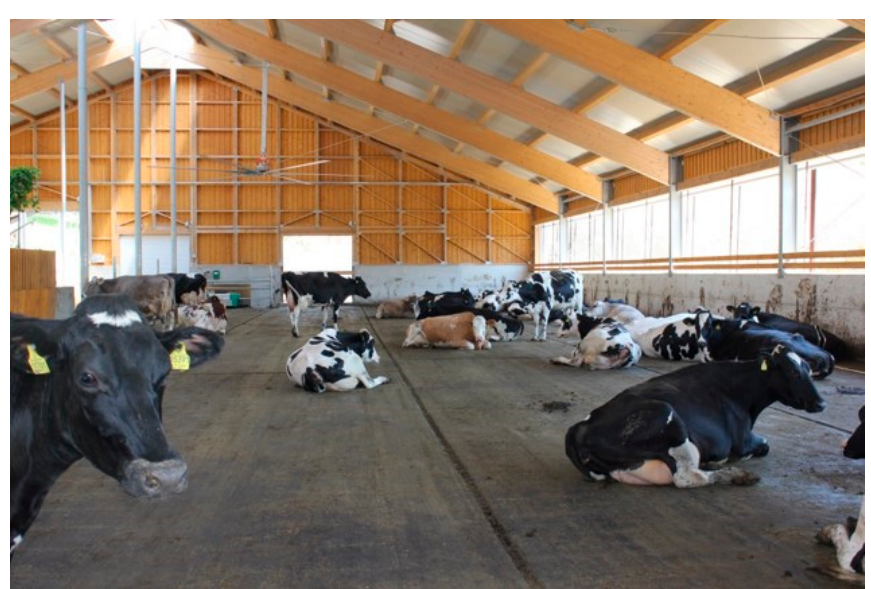
Figure 4. Free-walk housing system with artificial floor.